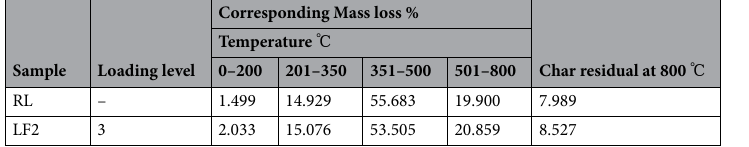
Table 2. Thermal parameters of RL and LF obtained from TG–DTA